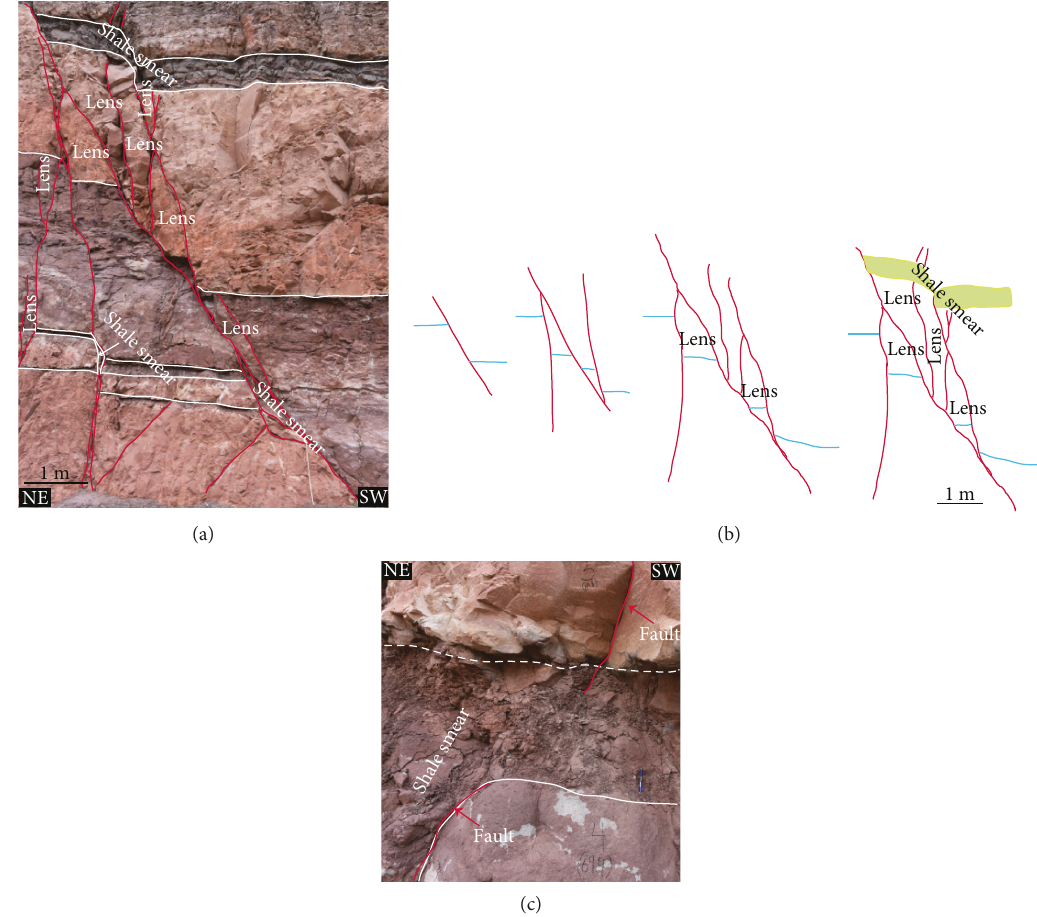
Figure 14: (a) A picture of the ANP outcrop that shows both fault core lenses trapped between relay zones and splays of the main fault, as well as the e ff ect of mechanical stratigraphy on the fault core internal structure and geometry. (b) From left to right, a series of sketches showing a possible faulting process for the outcrop in (a). The fault grows in length and through linkage of the splays, which results in trapping fault lenses. The shale layer has smeared into the fault core as soon as the fault has cut through it at a later stage. (c) E ff ect of mechanical stratigraphy on fault core geometry and thickness. Note that in shaley layers, the fault core become thicker and its boundaries are di ff use, while in sandstone layers, the boundaries are sharper and the fault core is thinner, unless it entraps host rock lenses. Note that faults are illustrated in red lines and bedding in white